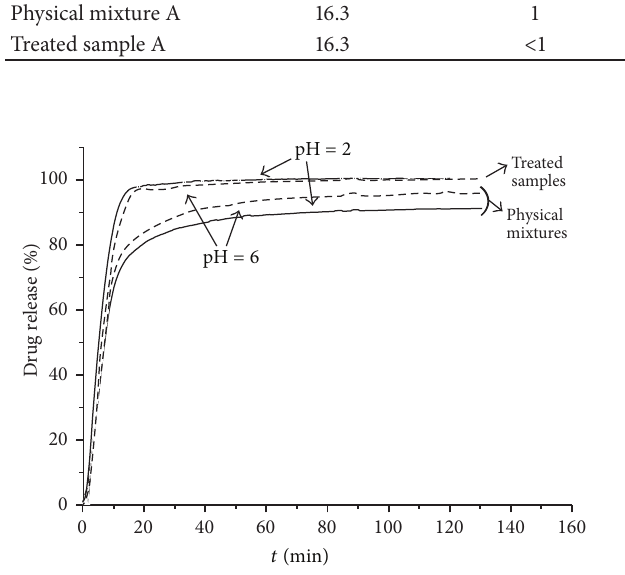
Figure 7: Comparison between the percent drug release profiles of tablets in an aqueous solution at different pH values (solid line: pH = 2 ; dashed line: pH = 6 ). The tablets were obtained from physical mixture A (16.3% KP) and sample A (16.3% KP, treated at 40 ∘ C, 20 MPa,